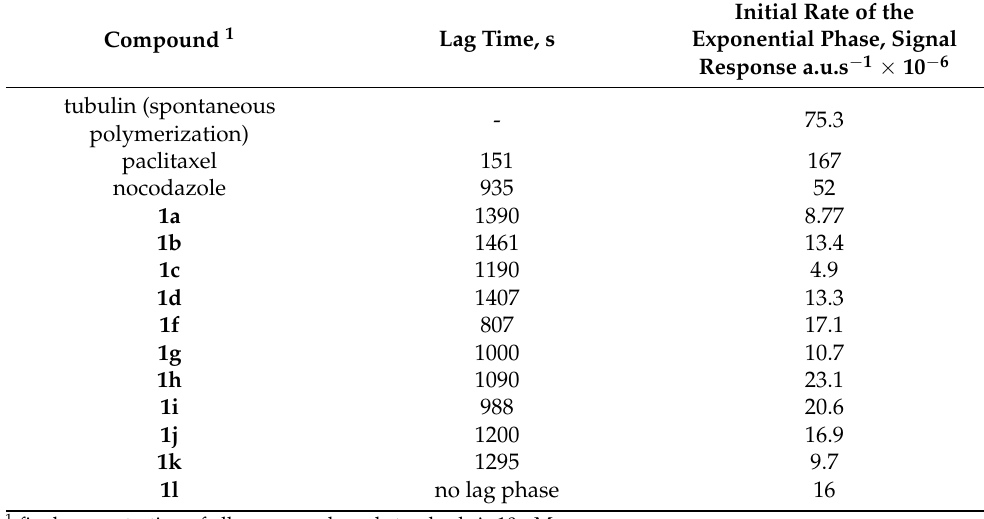
Initial Rate of the Exponential Phase, Signal